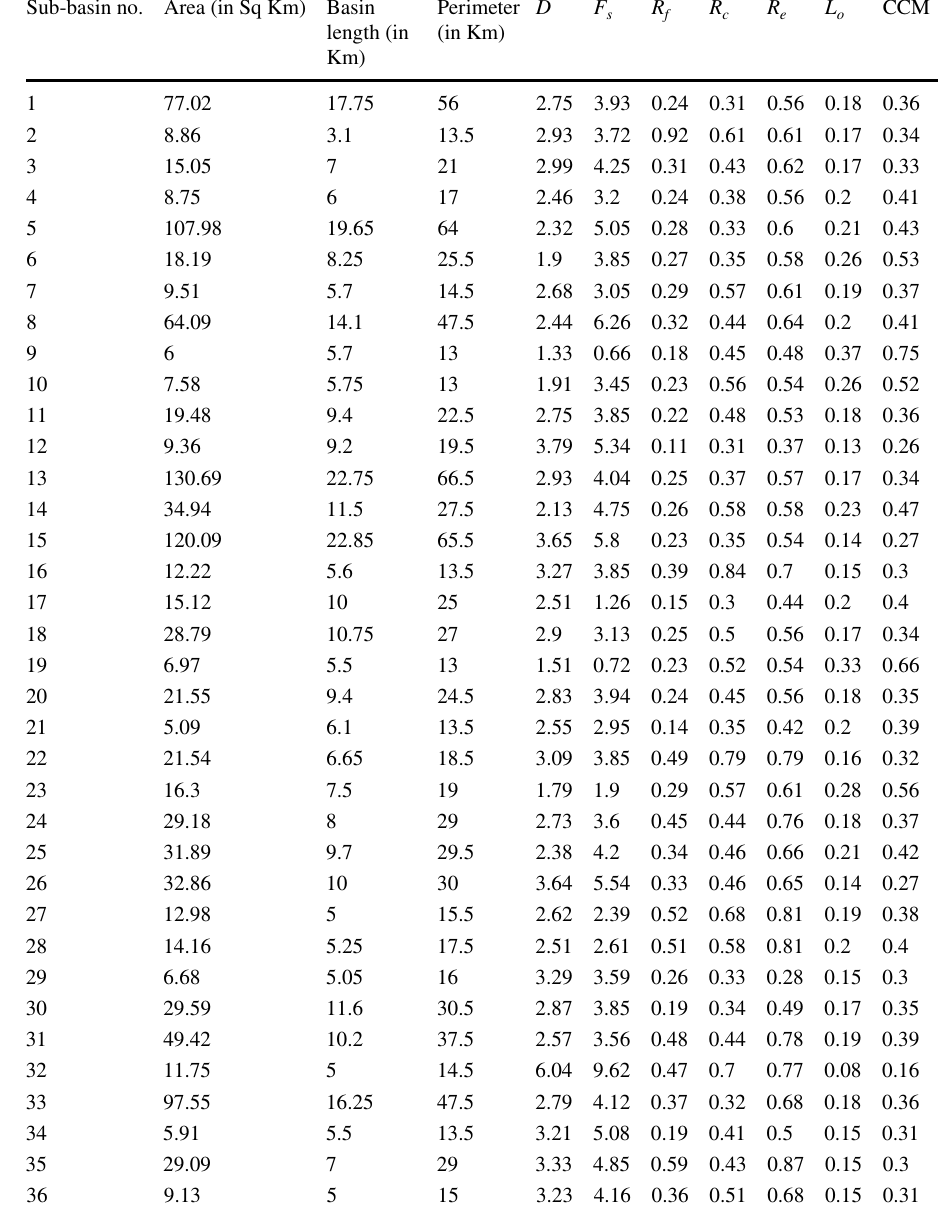
Sub-basin no. Area (in Sq Km) Basin